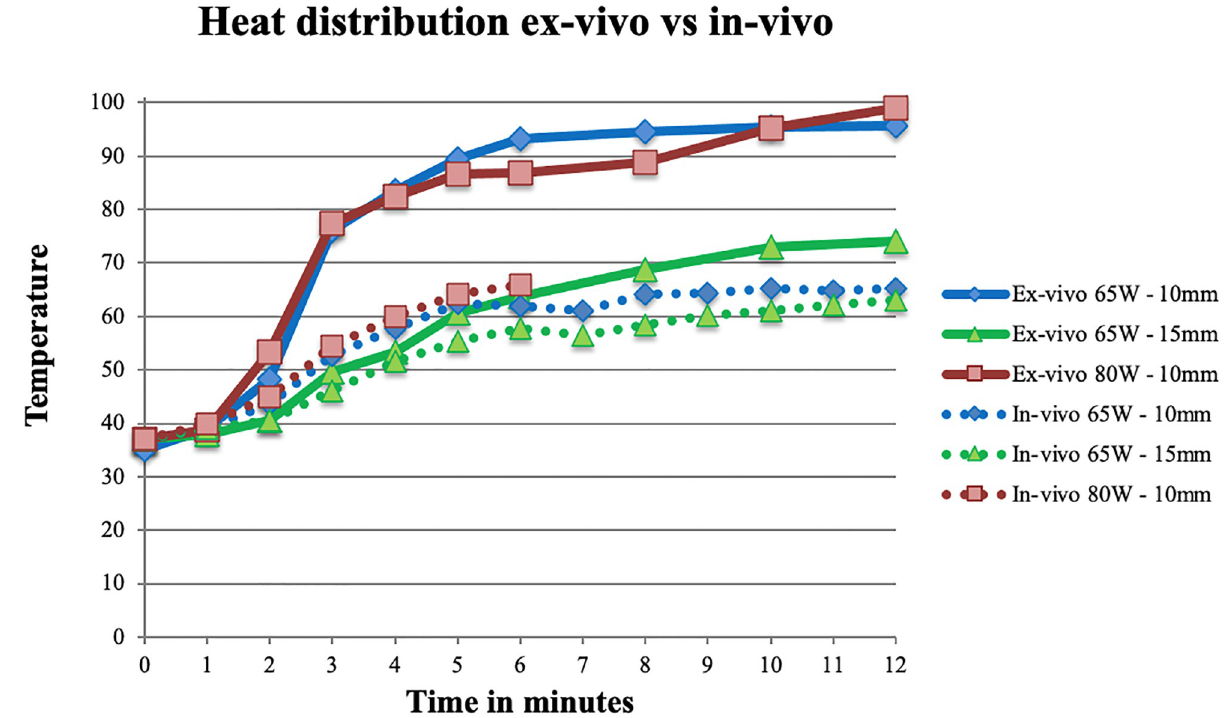
Fig 6. Heat distribution ex-vivo vs in-vivo. In-vivo temperatures are significantly lower.